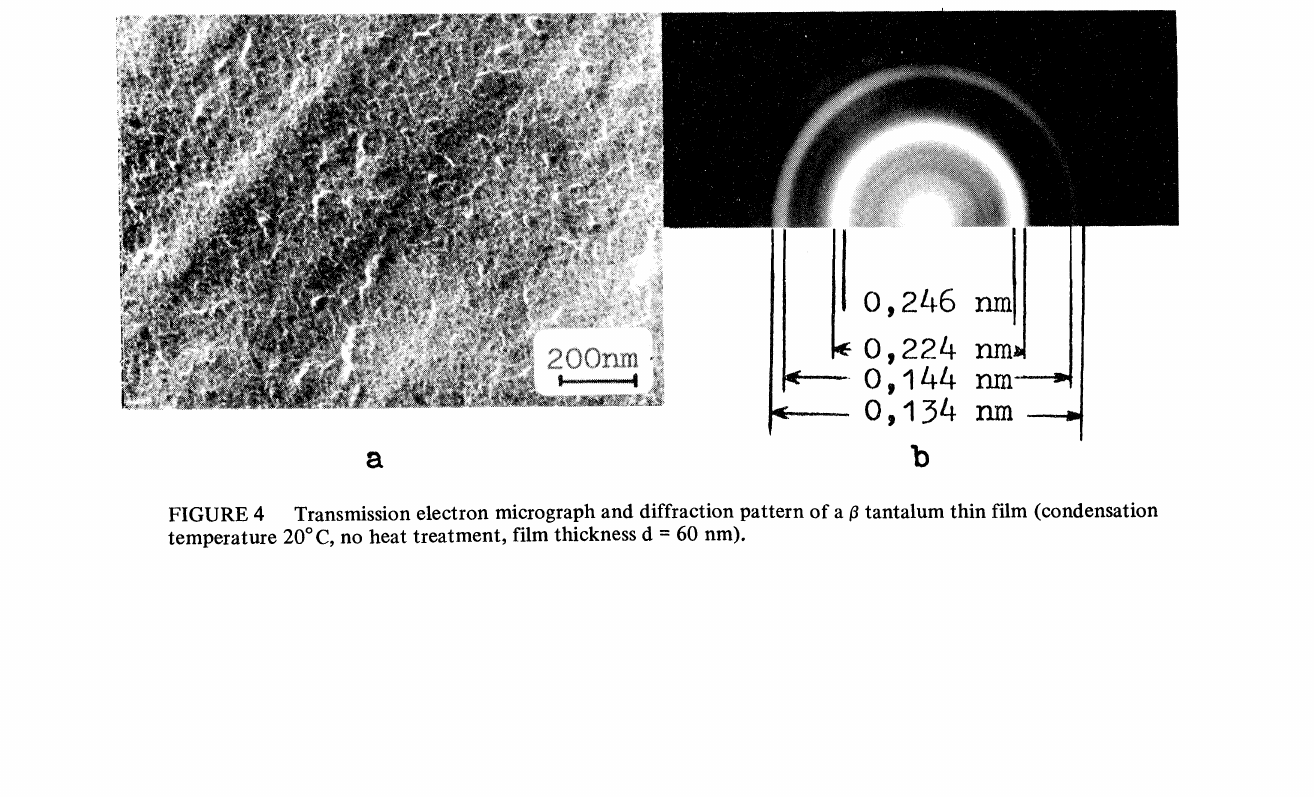
FIGURE 4 Transmission electron micrograph and diffraction pattern of a # tantalum thin film (condensation temperature 20 C, no heat treatment, film thickness d 60